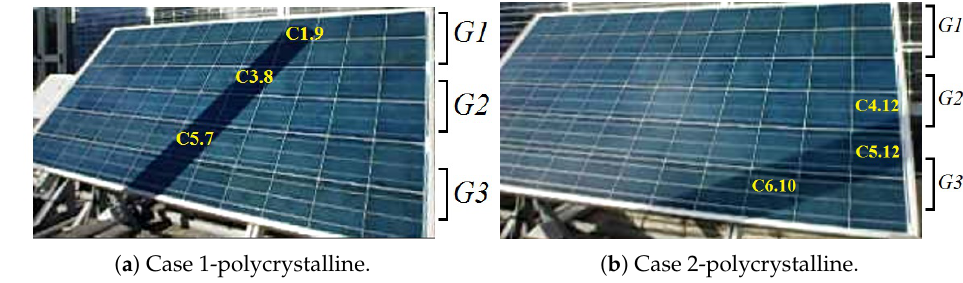
Figure 15. Experimental tests for polycrystalline PV